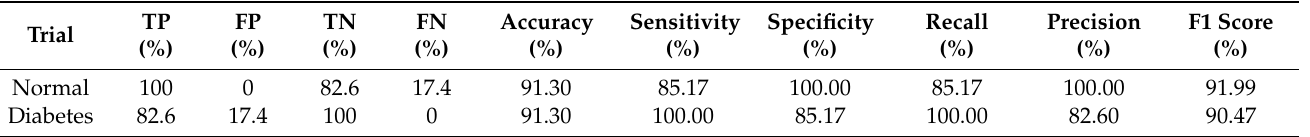
Table 7. Classification performance of super vector machine classifier.